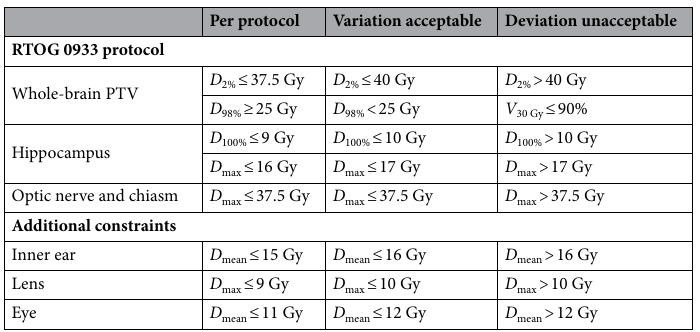
Table 1. Dose criteria of RTOG 0933 protocol and additional constraints used in the current